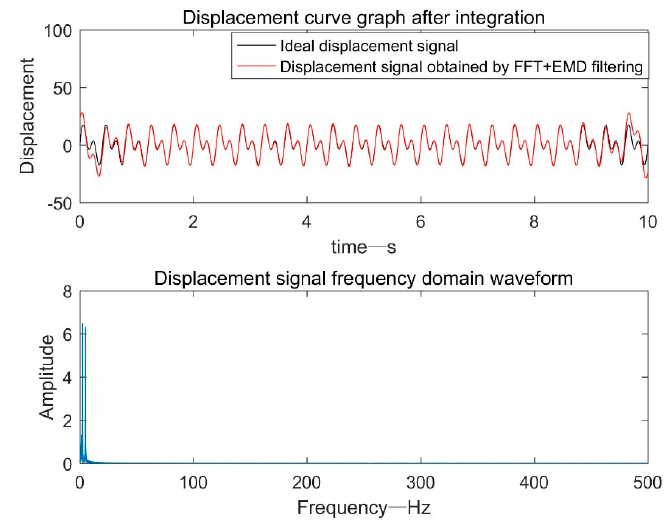
Figure 7. Displacement signal after FFT + EMD adaptive filtering.